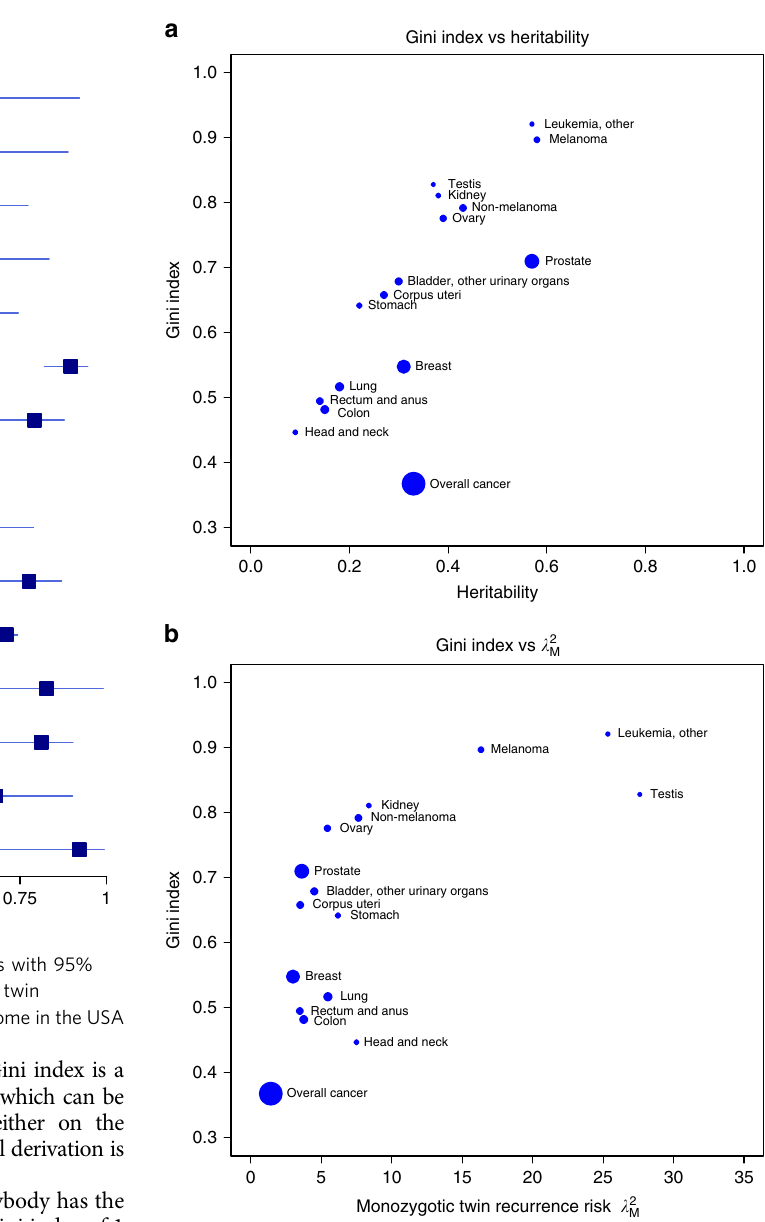
Fig. 3 Gini indices, h 2 estimates and twin recurrence risks are not co-linear. a The relation between Gini indices and heritability estimates are displayed for 15 common cancers. b The relation between Gini indices and monozygotic twin recurrence risks ( λ M ). The area of each circle is proportional to the life-time risk of the correspondin